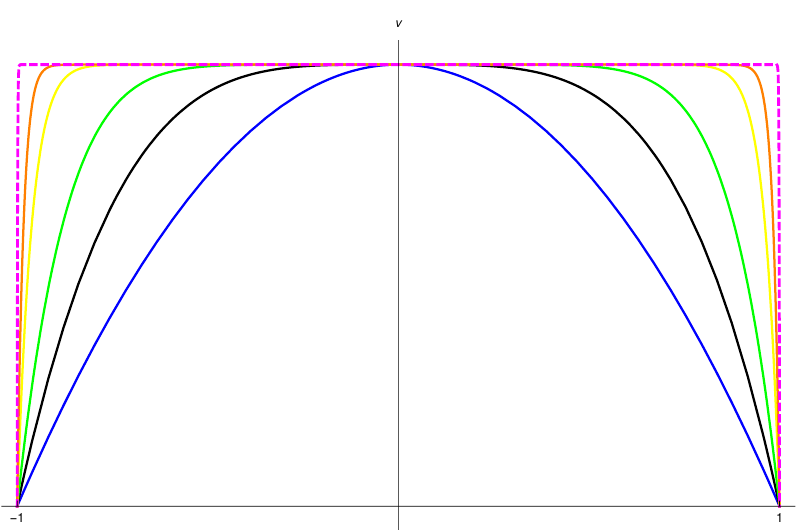
Figure 6 . Plot of the higher order potential for increasing values of (even) n . The point of interest to us here is that the value of the potential drops by an O (1) fraction within a (cid:12)eld distance of O (1) for all values n